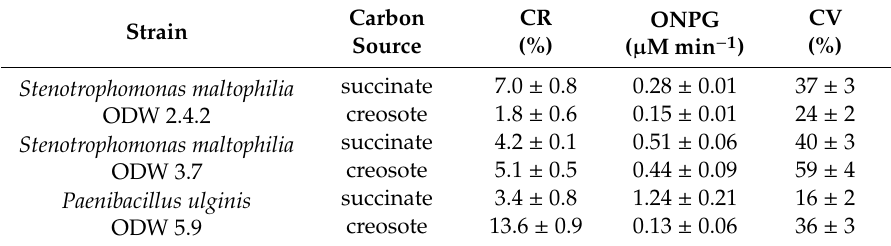
Table 2. Bacteria cell wall properties described by the Congo red adsorption assay (CR), the inner and total membrane permeability tests (ONPG and CV, respectively). Carbon CR Strain Source